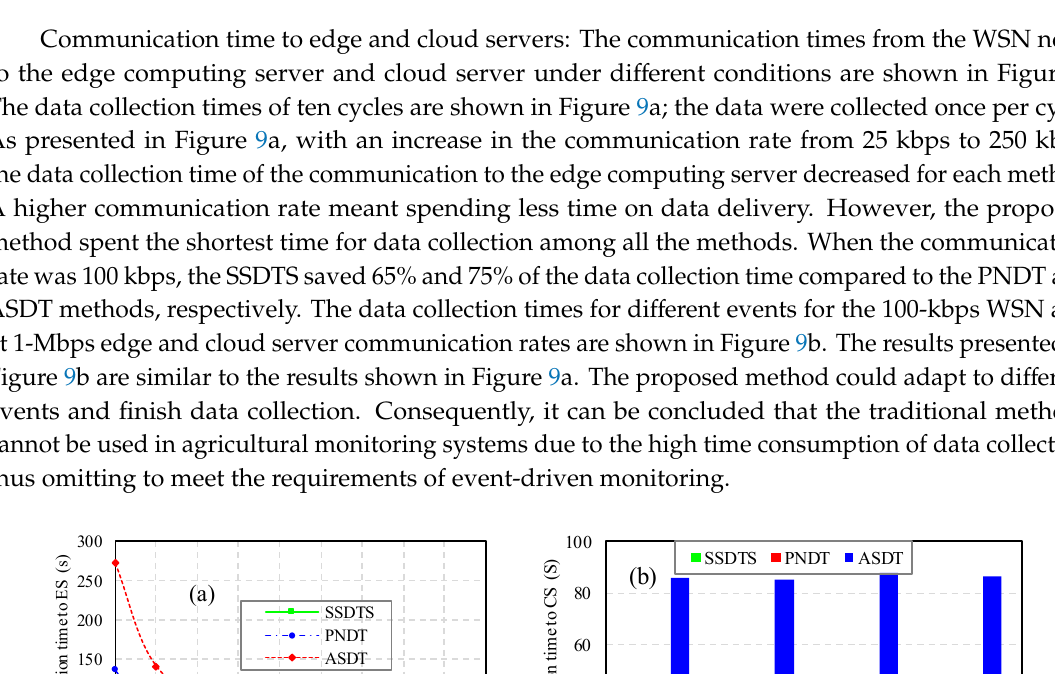
Figure 8. Sensing data size and energy consumption. ( a ) Sensing data size for different events, ( b ) Sensor energy consumption for different events.